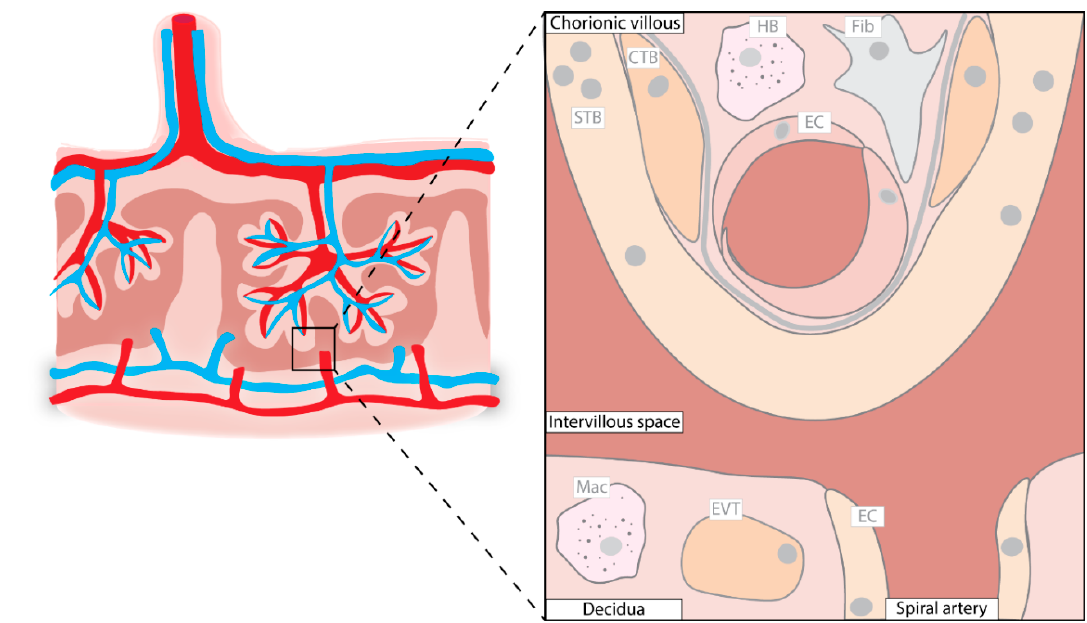
Figure 1. Schematic illustration of a term placenta with its most abundant cell types. CTB, cytotrophoblast; EC, endothelial cell; EVT, extravillous trophoblast; Fib, fibroblast; HB, Hofbauer cell; Mac, macrophage; STB, syncytiotrophoblast.